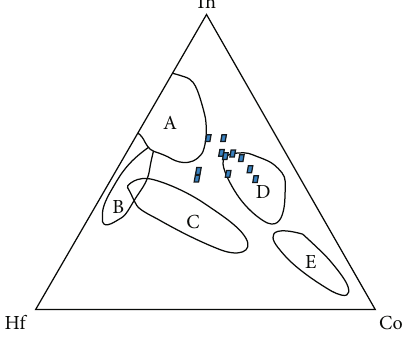
Figure 8: Th-Hf-Co provenance discrimination diagram [38]: A — felsic volcanic rocks; B — quartzite from cratonic basin; C — feldspar sandstones; D — shale (average upper continental crust); E — graywackes